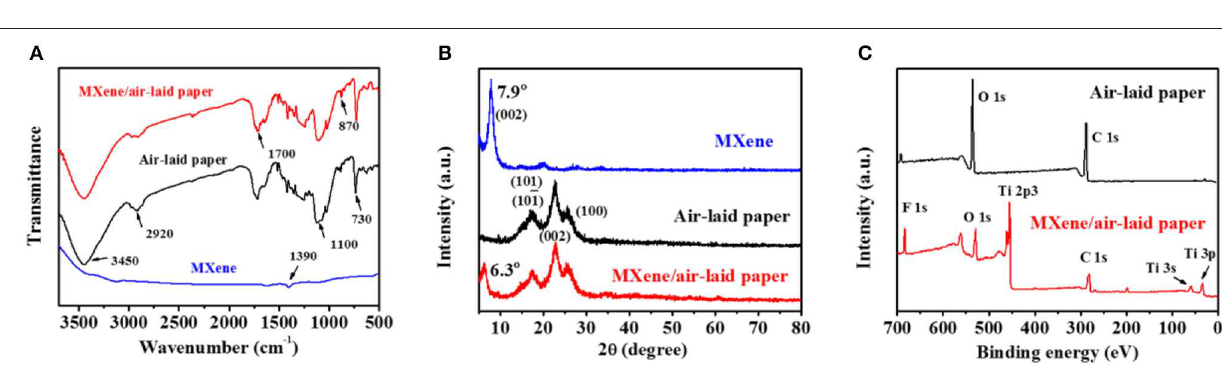
FIGURE 2 | (A) FTIR spectra of the original air-laid paper, MXene, and composite paper (MP-20); (B) XRD patterns of the original air-laid paper, MXene, and composite paper (MP-20); (C) XPS survey spectra of the original air-laid paper and composite paper